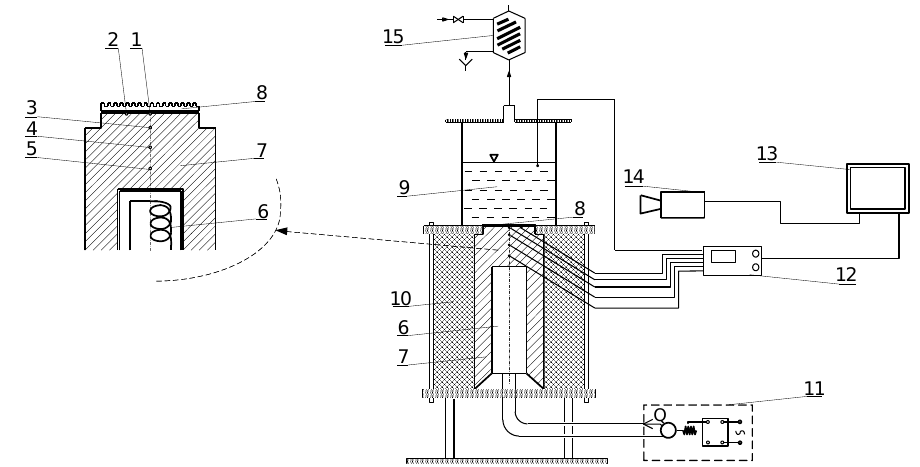
Figure 4. The testing facility: 1 and 2, thermocouples below the specimen; 3,4 and 5, thermocouples within the solid block; 6, heating device; 7, solid block; 8, laser treated specimen; 9, pool of fluid; 10, high temperature insulating material; 11, power supply unit; 12, temperature recording system, 13, measurements collection unit; 14, camera; 15, water-cooled coil.